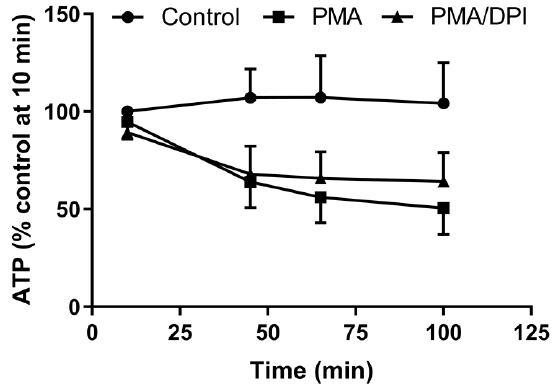
Figure 5. Effect of DPI on neutrophil ATP levels. ATP was measured at the indicated times in unstimulated (Control) neutrophils and cells stimulated with PMA in the presence or absence of DPI. PMA reduced cellular ATP in an oxidant-independent manner. Data are means and the range of two separate experiments.